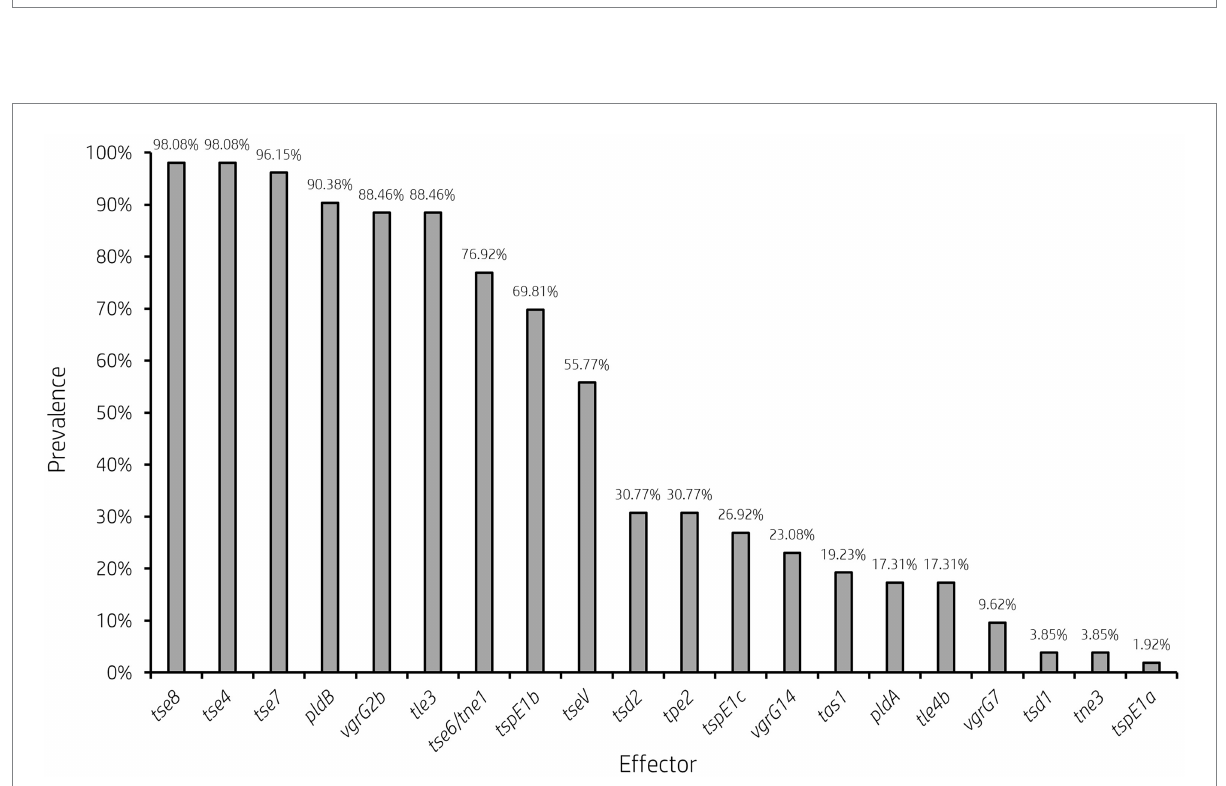
FIGURE 5 Prevalence of accessory T6SS effector encoding genes varies across clinical P. aeruginosa isolates. Bar graph showing the prevalence of select characterised and putative T6SS effector genes within 52 clinical P. aeruginosa isolates under